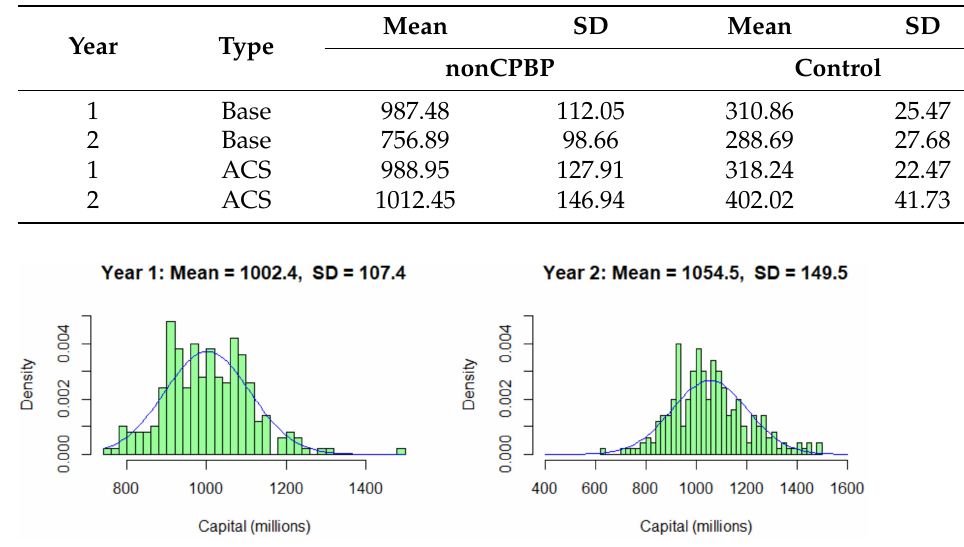
Figure 2. Histograms of 1- and 2-year nonCPBP predictions using the ACS scenario, showing fitted normal curves. The corresponding histograms for the base scenario are similar.